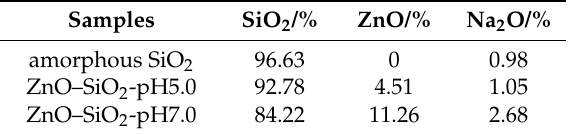
Table 1. XRF of amorphous SiO 2 , ZnO–SiO 2 -pH5.0 and ZnO–SiO 2 -pH7.0. Samples